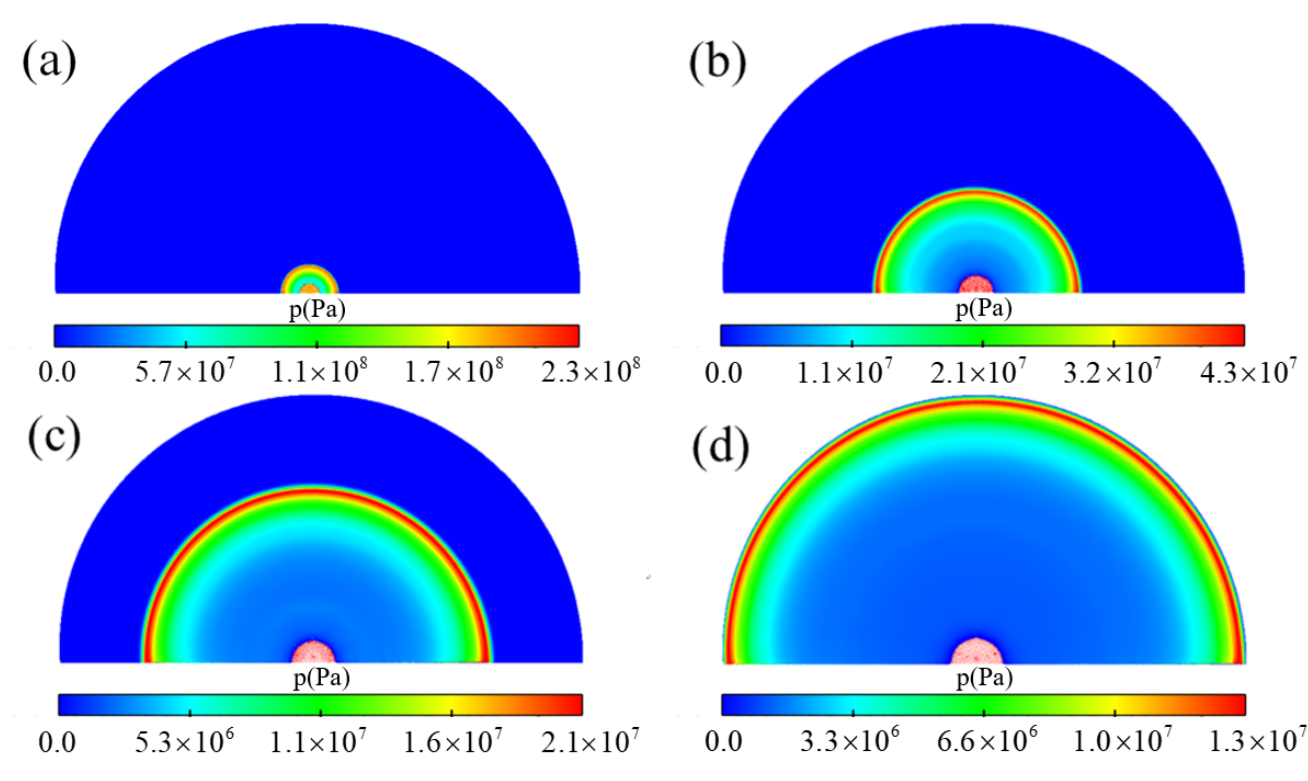
Figure 13. SPH simulations for high pressure bubble expansion and shock wave propagation at different time instants [168] (( a ) t = 0.28 ms; ( b ) t = 1.4 ms; ( c ) t = 2.52 ms; ( d ) t = 3.92